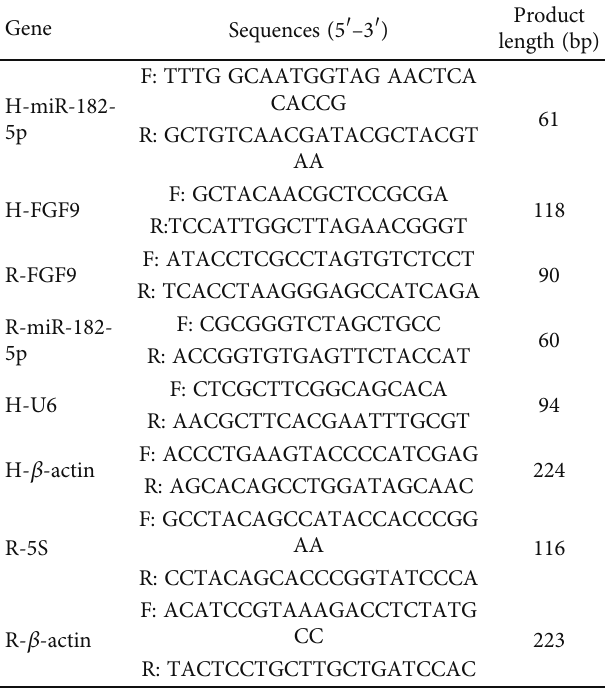
Table 1: RT-qPCR primer sequences.